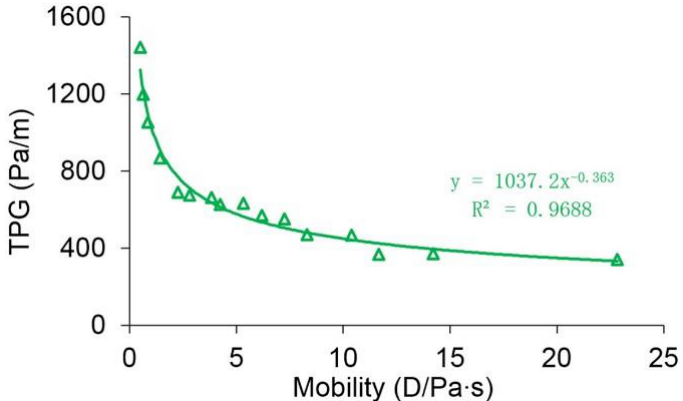
Figure 7. The relationship between the TPG and mobility.